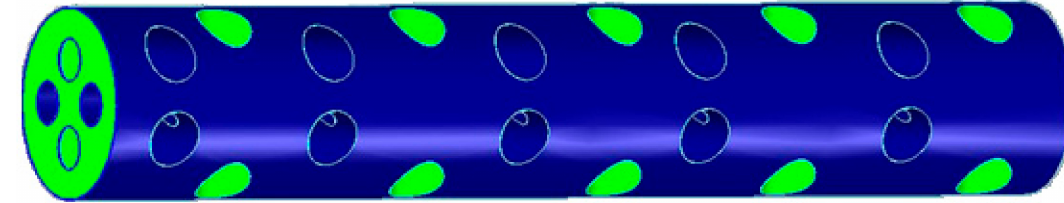
Figure 1. Standard etalon work-piece for measuring the refractive index of